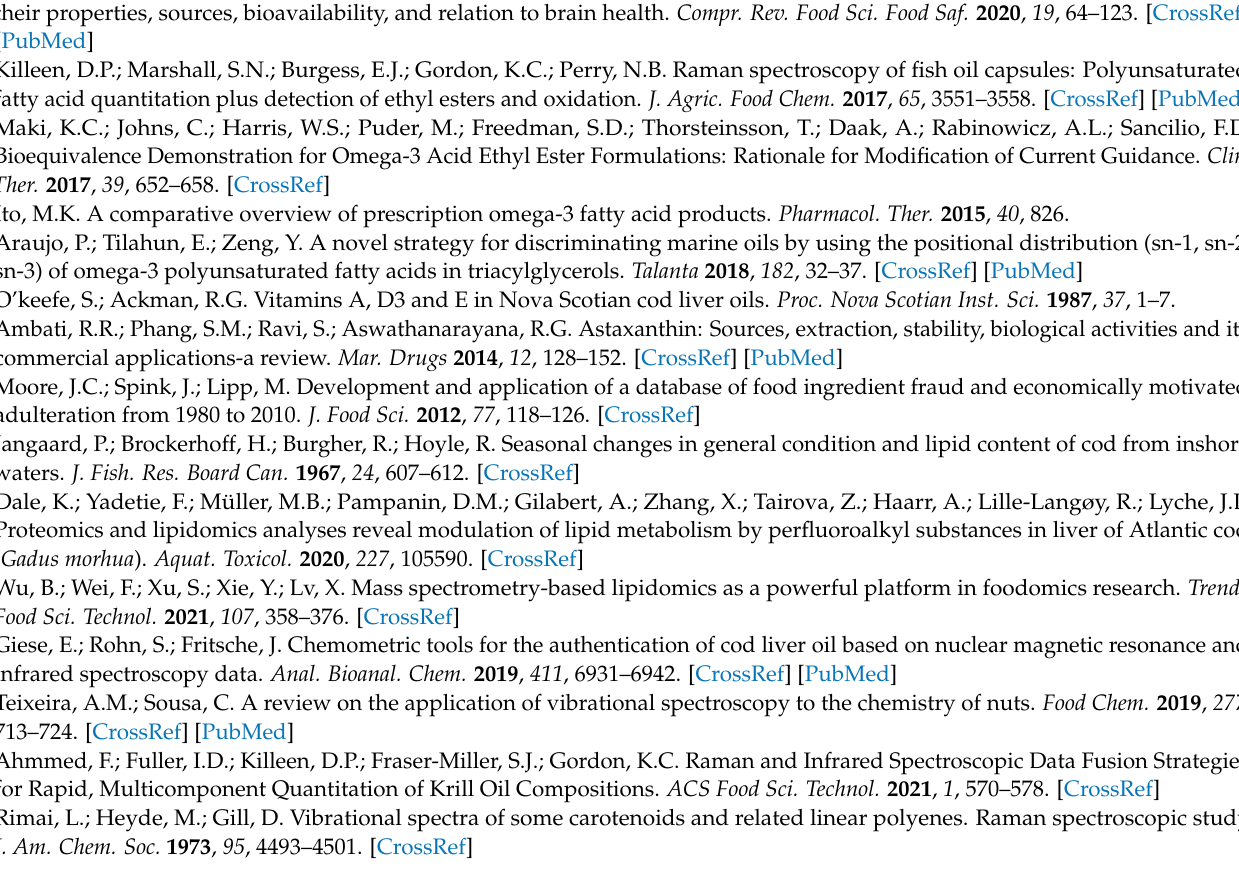
Figure S7: PLSR calibration lines and regression coefficients for the quantitative prediction of the PO concentration in global (a,b), individual CLO, (c,d) and SO (e,f) by low-level fusion; Figure S8: PLSR calibration lines and regression coefficients for the quantitative prediction of the O3C concentration in global (a,b), individual CLO (c,d), and SO (e,f) by low-level fusion; Figure S9: PLSR calibration lines and regression coefficients for the quantitative prediction of the FO concentration in global (a,b), individual CLO (c,d), and SO (e,f) by low-level